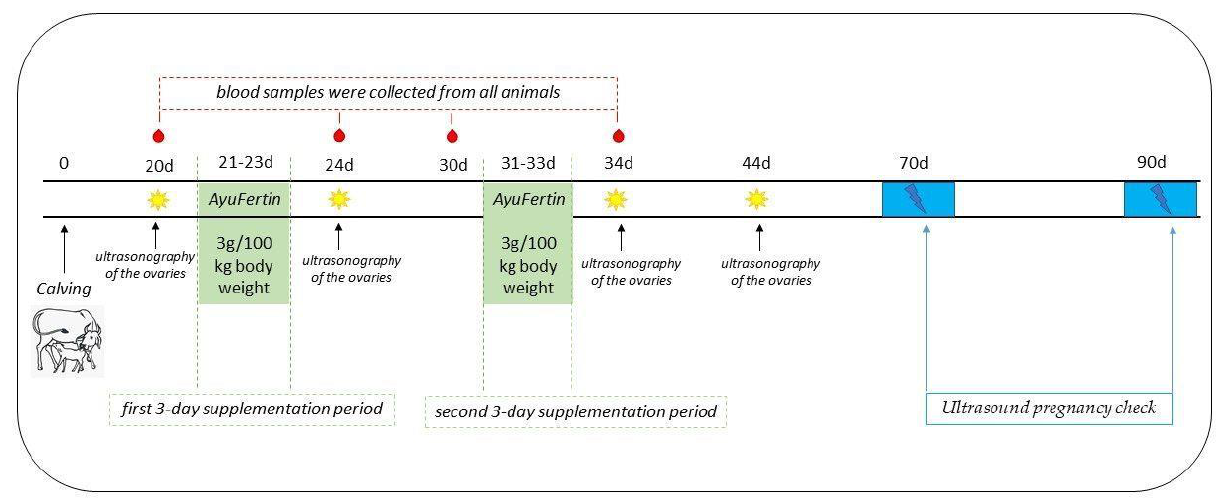
Figure 1. Scheme of the experimental